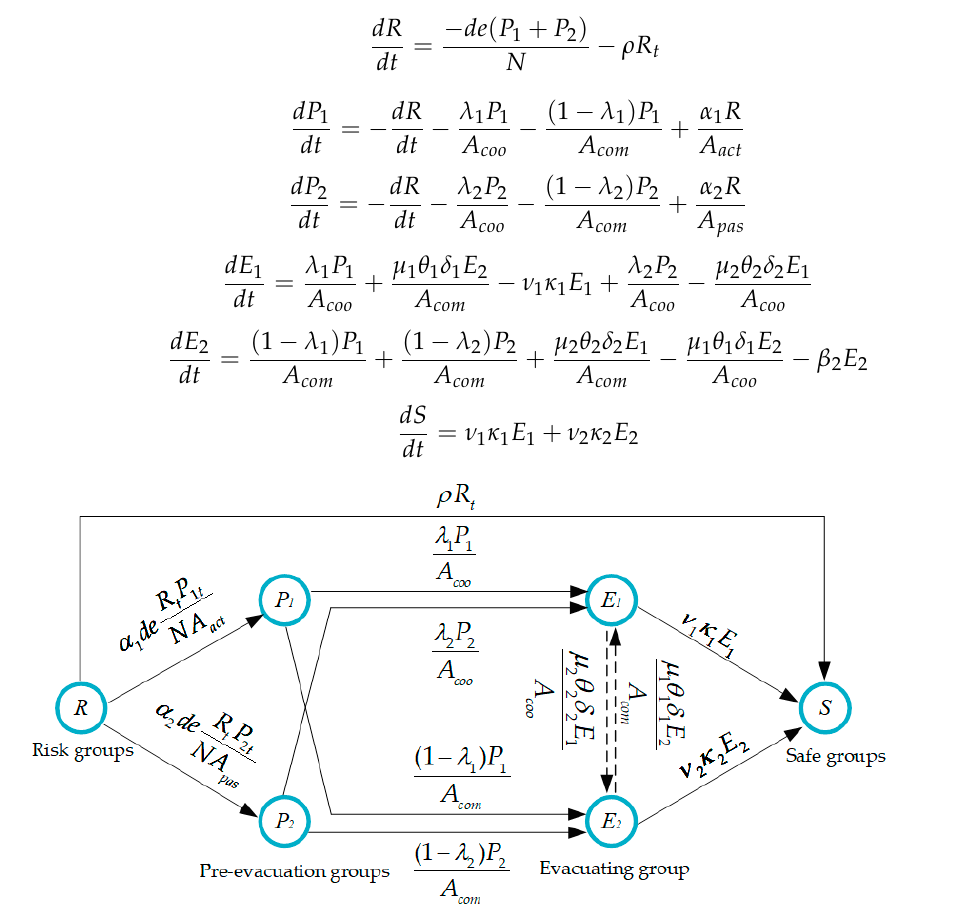
Figure 4. Model of the evolution of the state of the evacuated crowd on an underground platform.